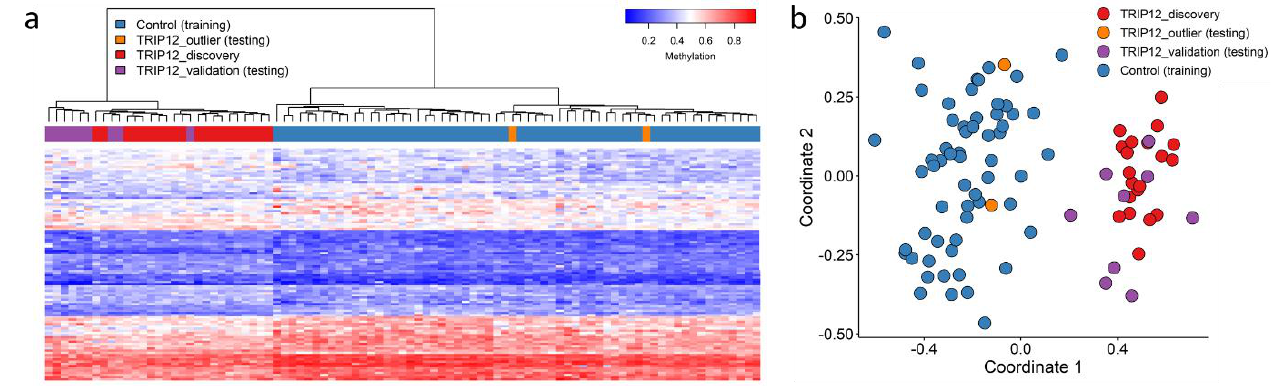
Figure 4. Validation of the Clark–Baraitser syndrome (TRIP12) episignature—validation cohort: ( a ) Euclidean hierarchical clustering (heatmap): each column represents a single TRIP12 case or control; each row represents 1 of the 105 CpG probes selected for the episignature. This heatmap shows segregation of the 9 TRIP12 validation cases (purple) with the 20 TRIP12 training (discovery) cases (red) from controls (blue). The 2 outlier cases (orange) remain segregated with controls; ( b ) Multidimensional scaling (MDS) plot shows segregation of TRIP12 cases (validation and discovery) from